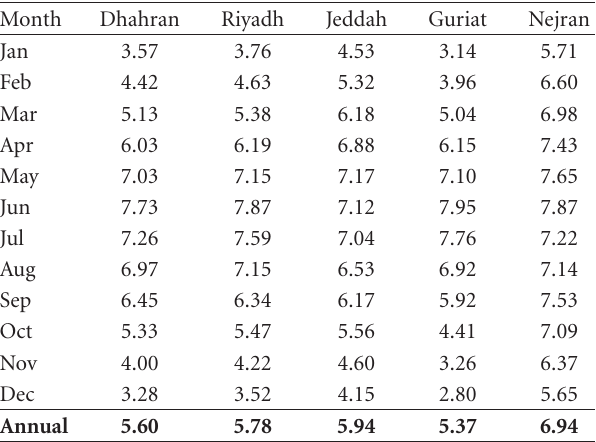
Table 2: Global solar radiation on horizontal surface (kWh/m 2